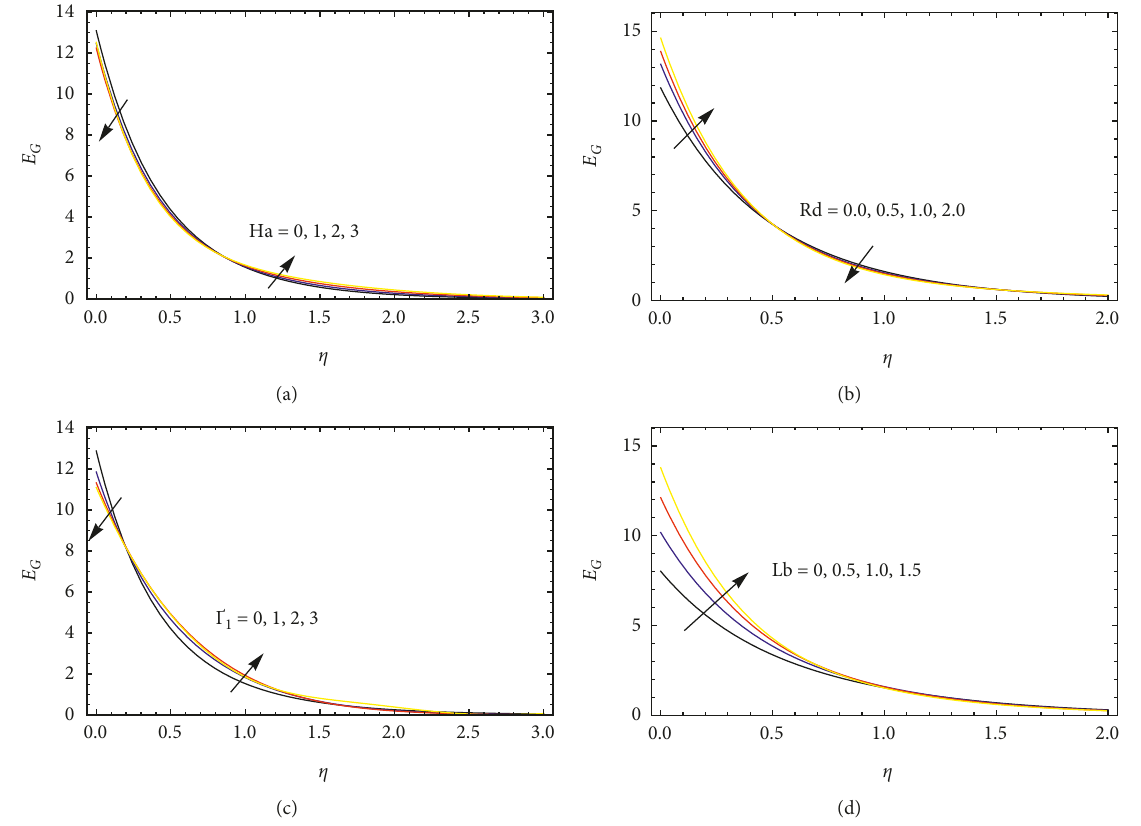
Figure 6: Entropy generation profile for different values of Ha, Rd, Γ